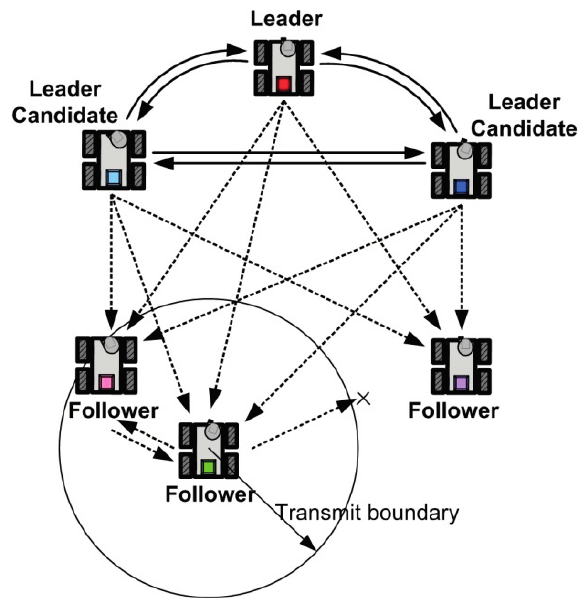
Figure 2. The combined communication